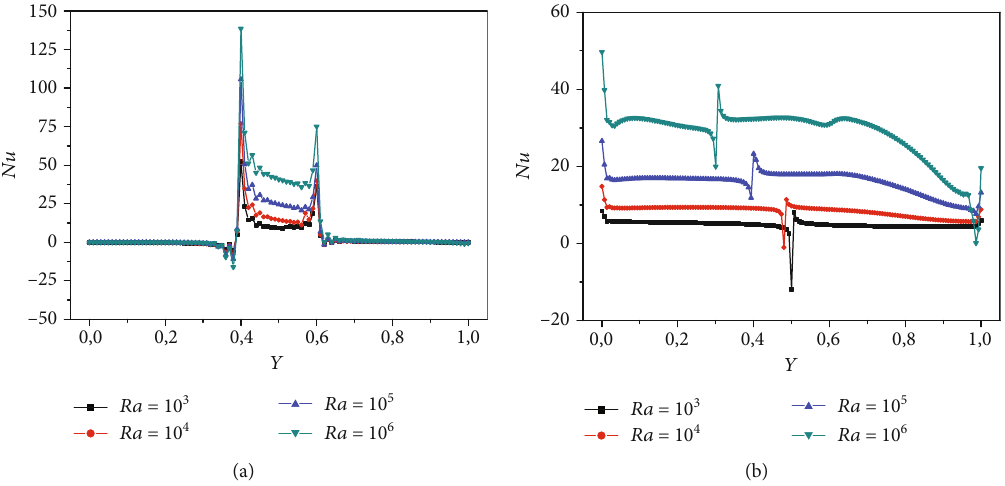
Figure 11: Nusselt number variation along the heated wall for hot chip (a) and cold chip (b), for h = H /5 .